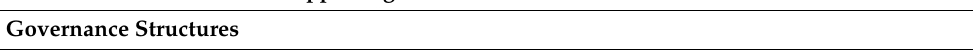
Table 2. Analytical categories translated into interview topics: example questions. Characteristics of AAS for Supporting SHM Governance Structures